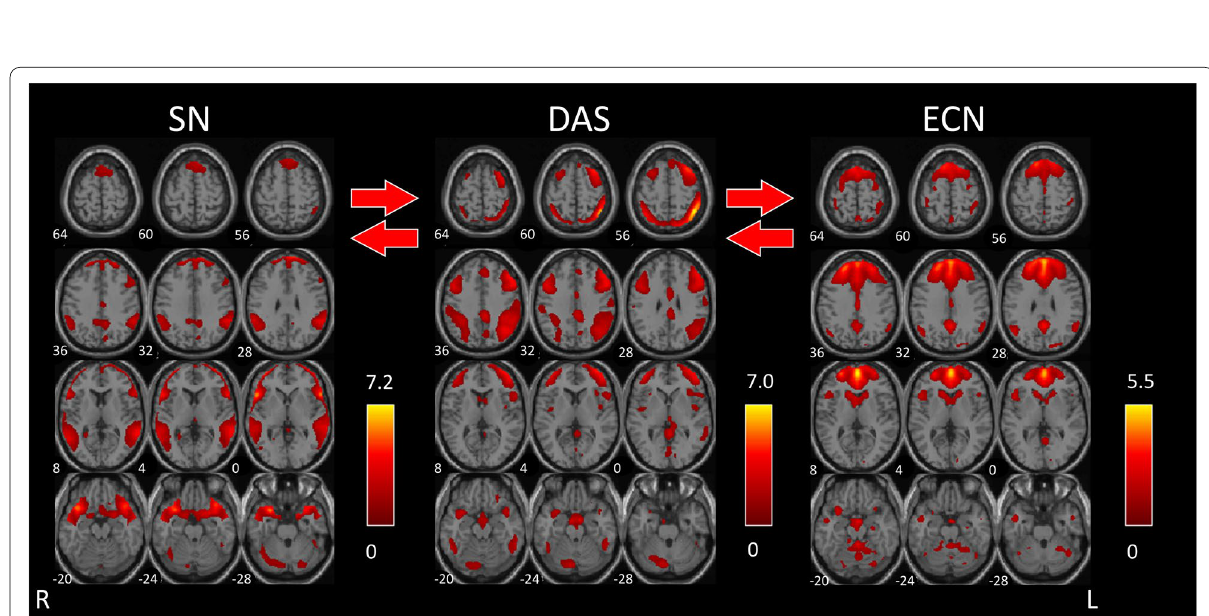
Fig. 3 In patients with migraine with aura, dorsal attention systems [DAS] were significantly connected to the executive control network [ECN] and with the Salience network [SN], after 4-min checkerboard visual stimulation vs. baseline resting state network connectivity. The images were co-registered in MNI space. The number under each brain image refers to the z-coordinate in Talairach space. The coloured bar on the right side of each network component reflects its functional connectivity map (FDR-corrected at p <